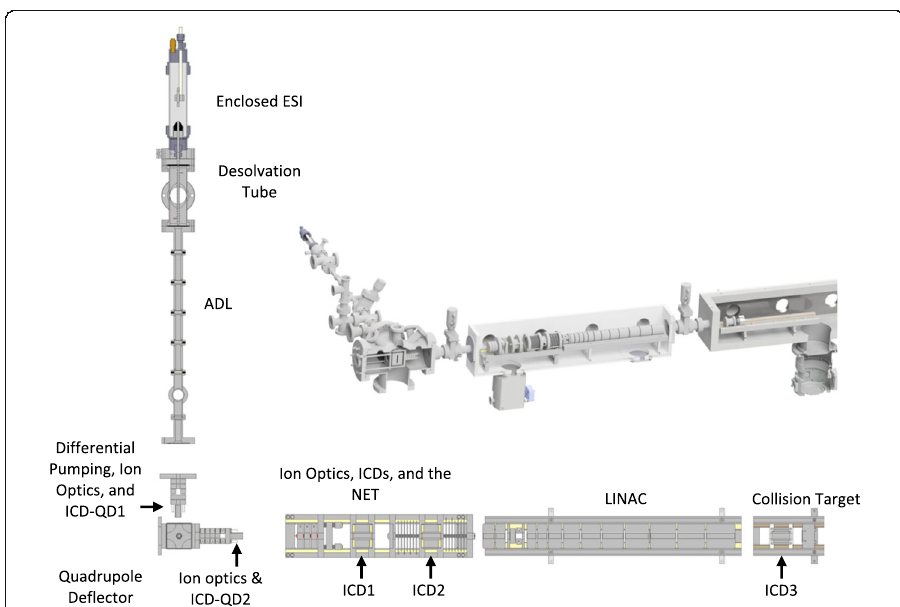
Fig. 1 Schematic and perspective view of the Aerosol Impact Spectrometer. Components starting from the charged aerosol source: Enclosed electrospray ionization (ESI); Desolvation tube; Aerodynamic Lens (ADL); Differential pumping, ion optics and image charge detector ICD-QD1; Quadrupole Deflector (QD), ion optics and ICD-QD2; Injection optics for Nanoparticle Electrostatic Trap (NET), including ICD1; NET, including ICD2; Injection optics; and 9-stage Linear Accelerator (LINAC); Final ICD (ICD3) and collision target. Locations of image charge detection tubes are indicated with a black